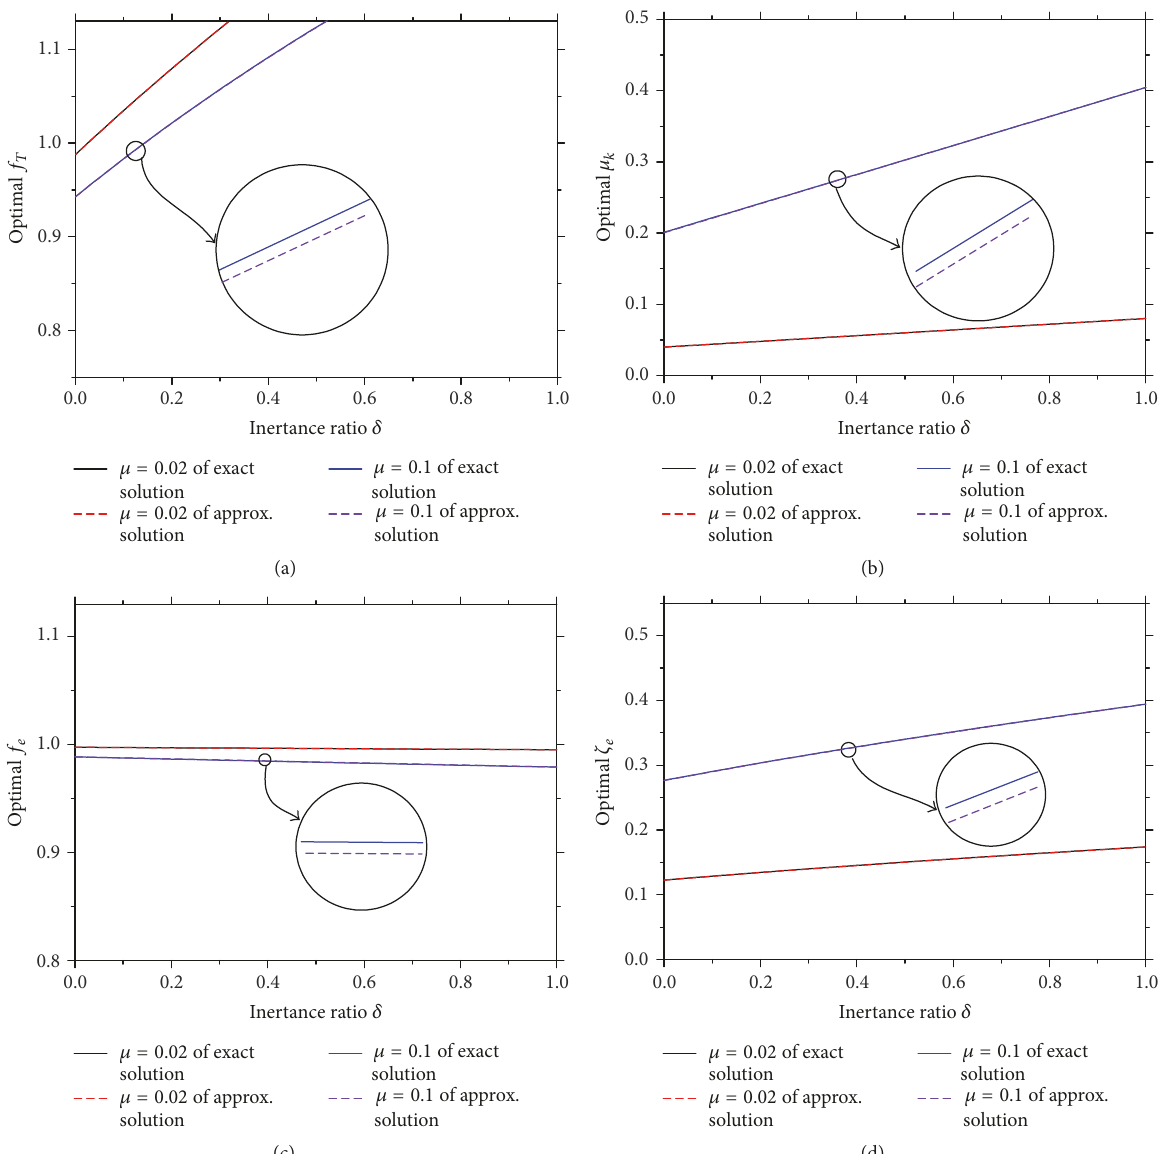
Figure 2: Graphical representations of 𝐻 2 tuning laws. (a) Optimal mechanical tuning ratio 𝑓 𝑇 ; (b) optimal electromagnetic mechanical coupling coefficient 𝜇 𝑘 ; (c) optimal electrical tuning ratio 𝑓 𝑒 ; (d) optimal electrical damping ratio 𝜁 𝑒 of exact and approximate solutions under different mass